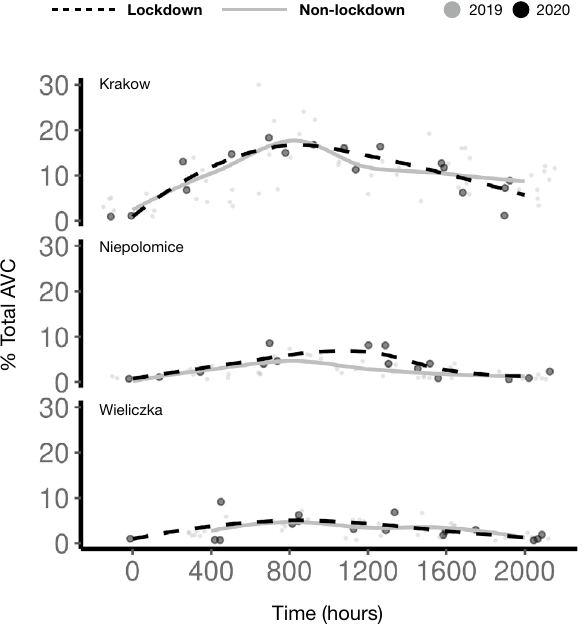
Figure 3. AVC during the lockdown. The LOESS fitted line plot represents the trend of percentage of total AVC (y-axis) across the location along the time